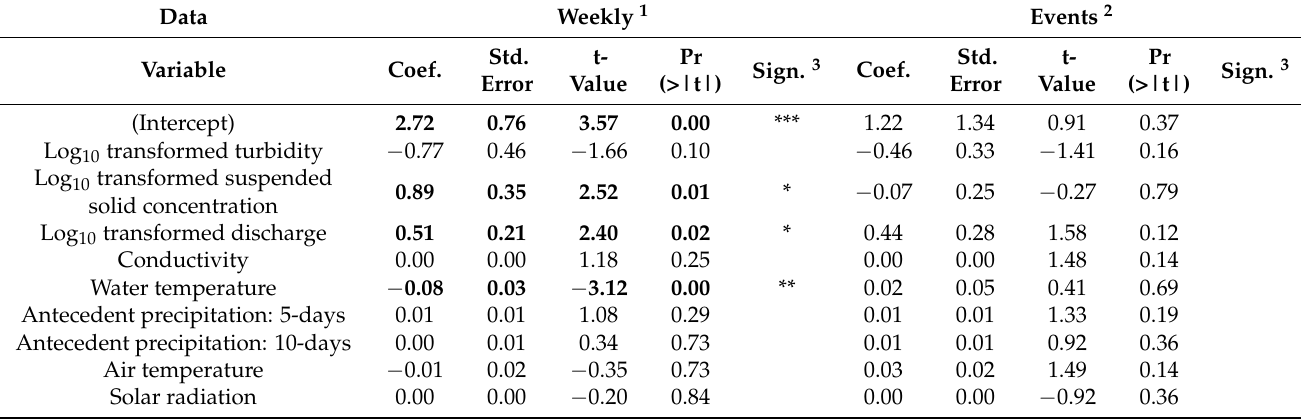
1 Residual standard error: 0.46 on 50 degrees of freedom (DF). Multiple R 2 : 0.67, F-statistic: 11.49 on 9 and 50 DF, p -value < 0.0001. Adjusted R 2 : 0.62. Leave-one-out cross-validation R 2 : 0.54. 2 Residual standard error: 0.43 on 64 DF. Multiple R 2 : 0.30, Adjusted R 2 : 0.20.